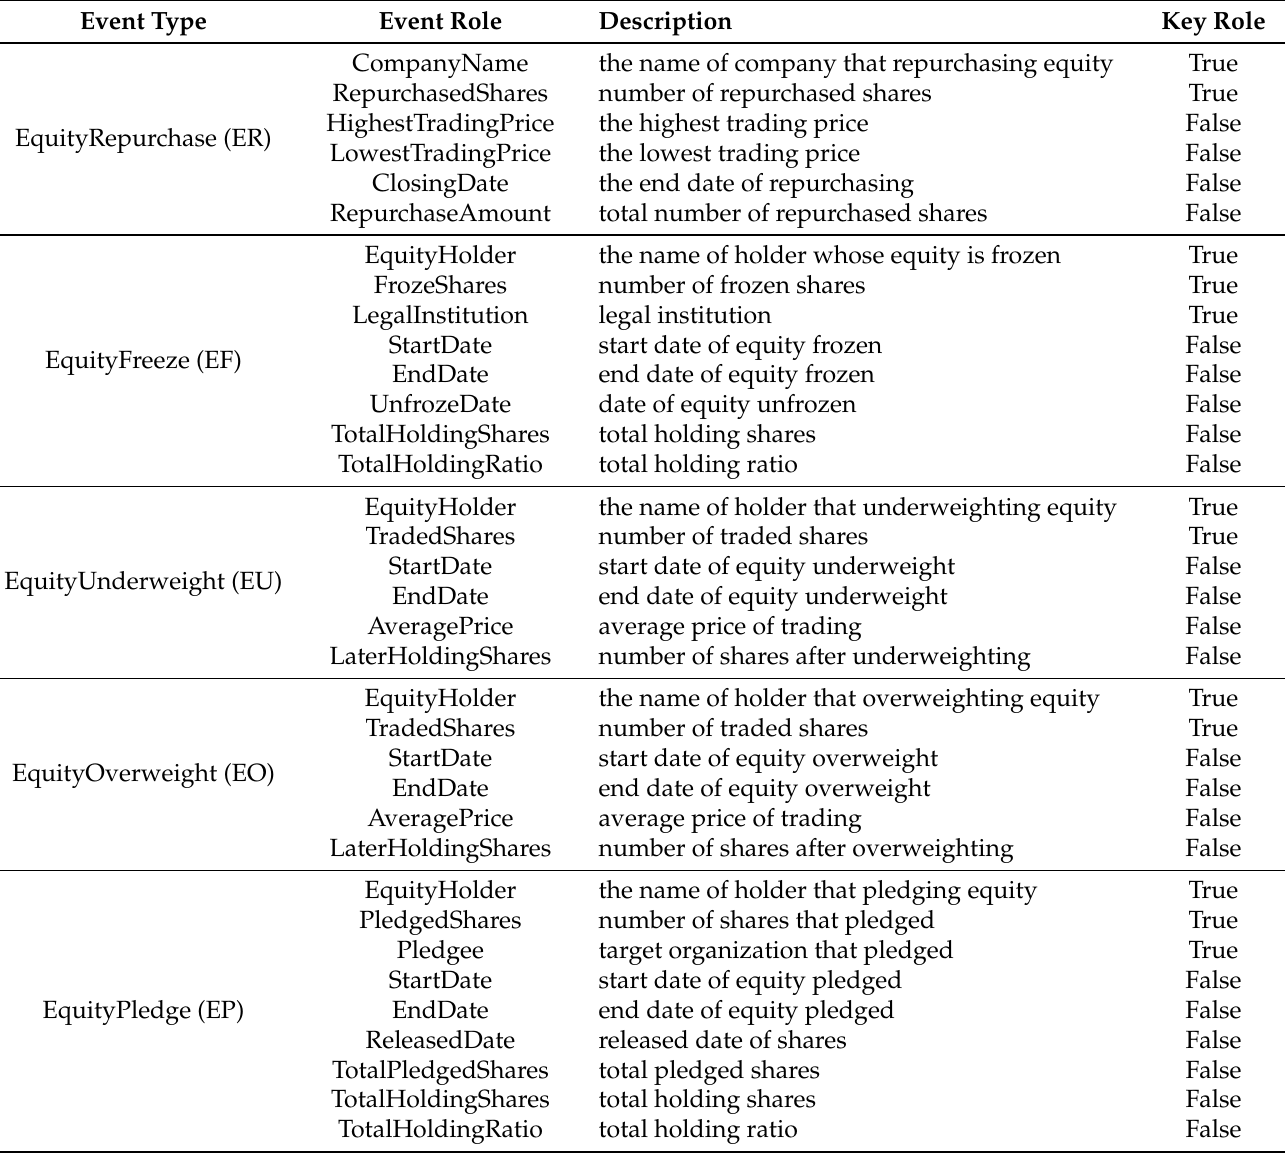
Table 1. Event ontology of ER, EF, EU, EO, and